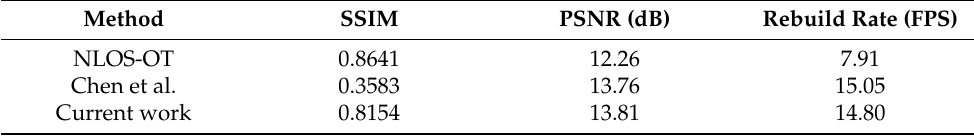
Table 2. Reconstruction quality comparison of the methods on the captured